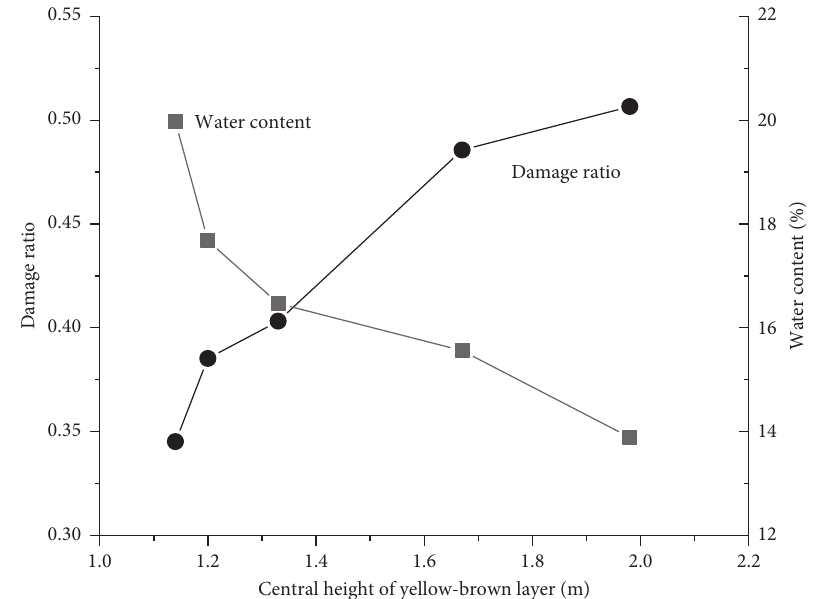
Figure 3: The variations of damage ratio and water content as a function of the central height of the yellow-brown layers in slope